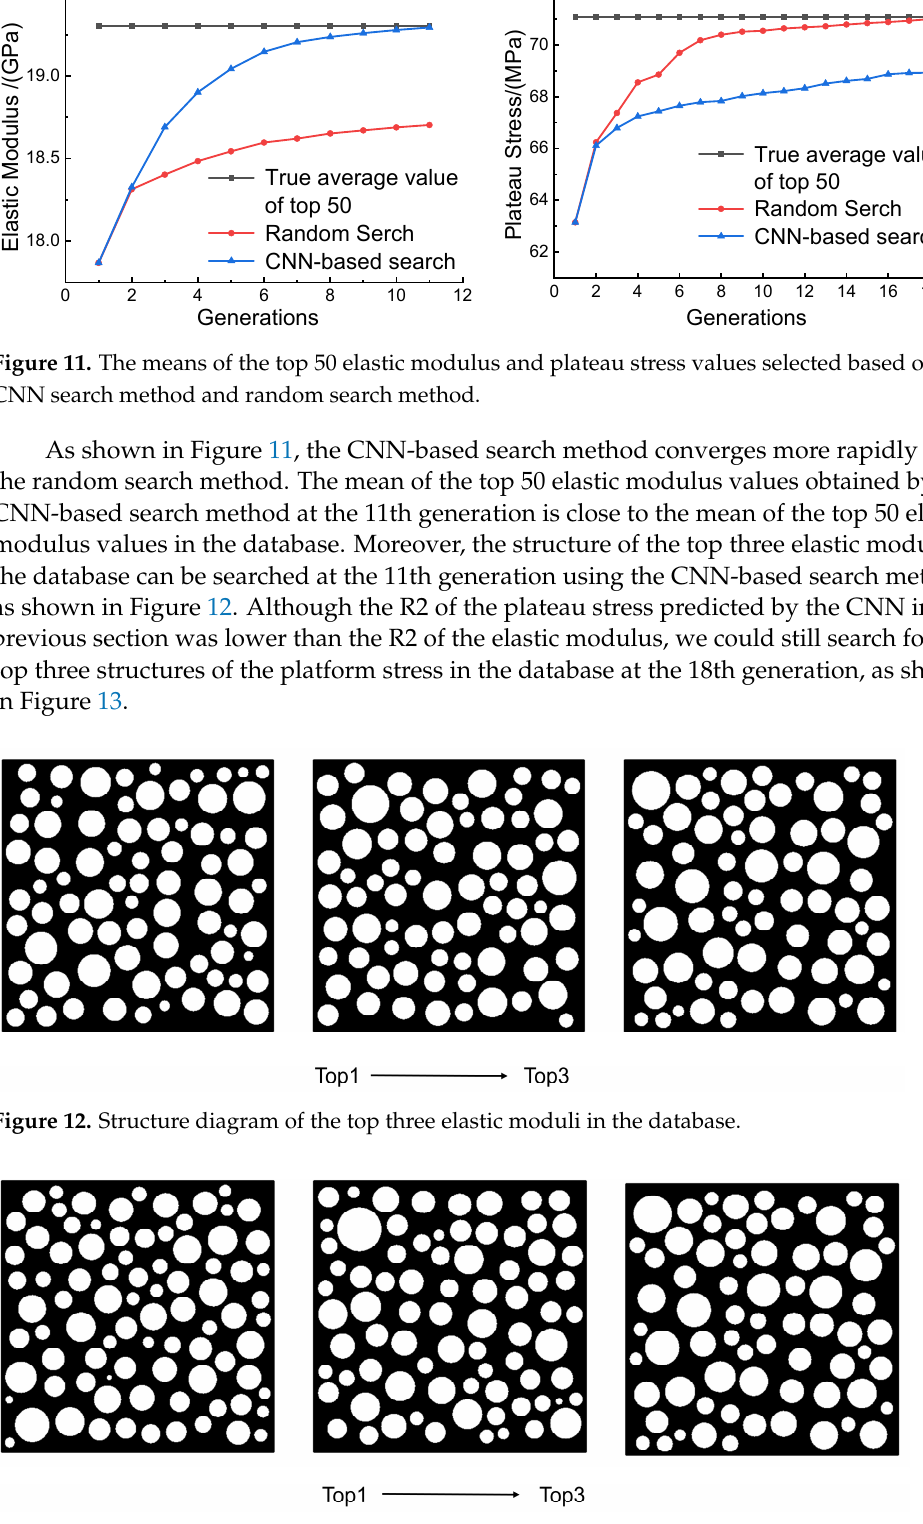
Figure 10. Flowchart of CNN ‐ based search method.